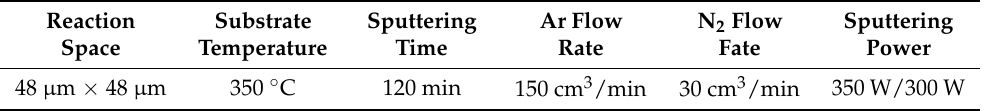
Table 3. Experimental